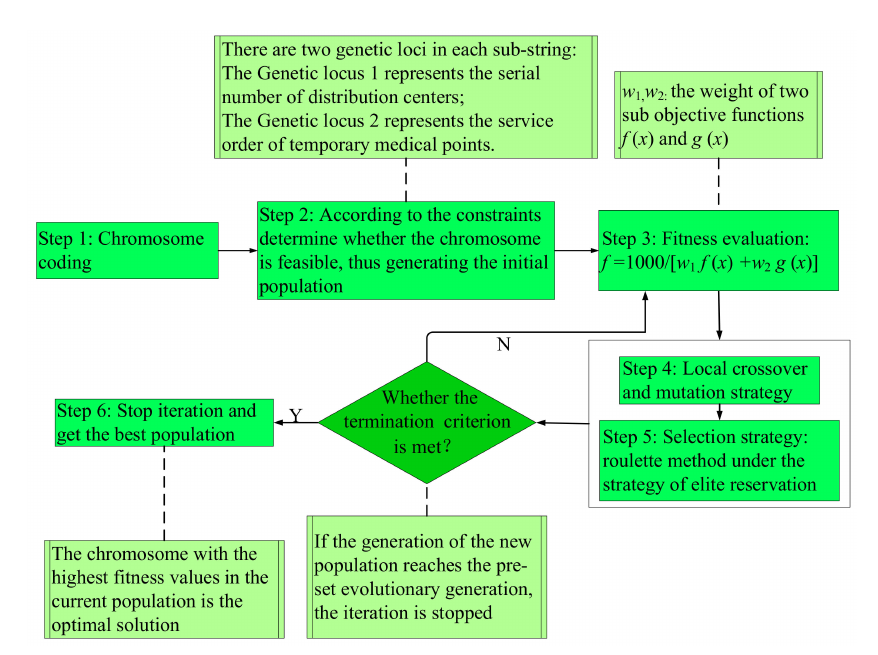
Figure 2. The specific process of the hybrid genetic